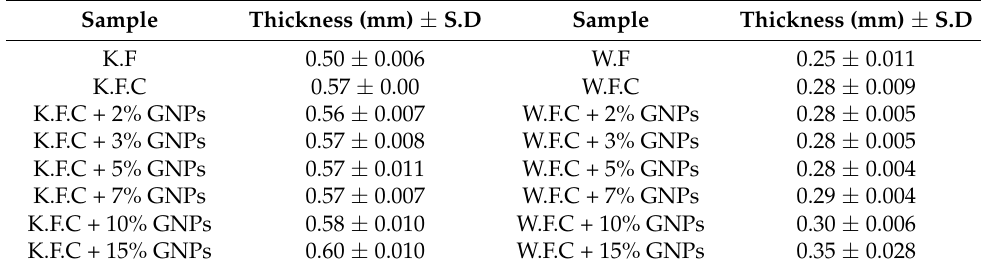
Table 2. Textile samples and their thickness